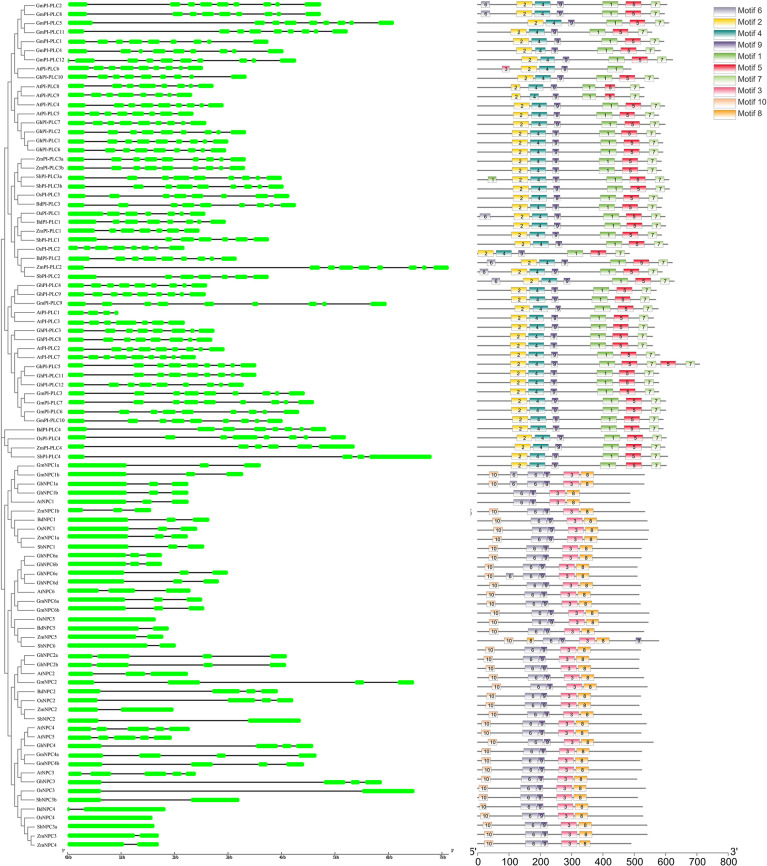
Phylogenetic relationships, gene structures, and conserved protein motifs of maize PLC family. Green boxes indicate exons, and black lines indicate introns. The motifs, numbered 1–10, are displayed in different colored boxes. The length of the protein can be estimated using the scale at the bottom.